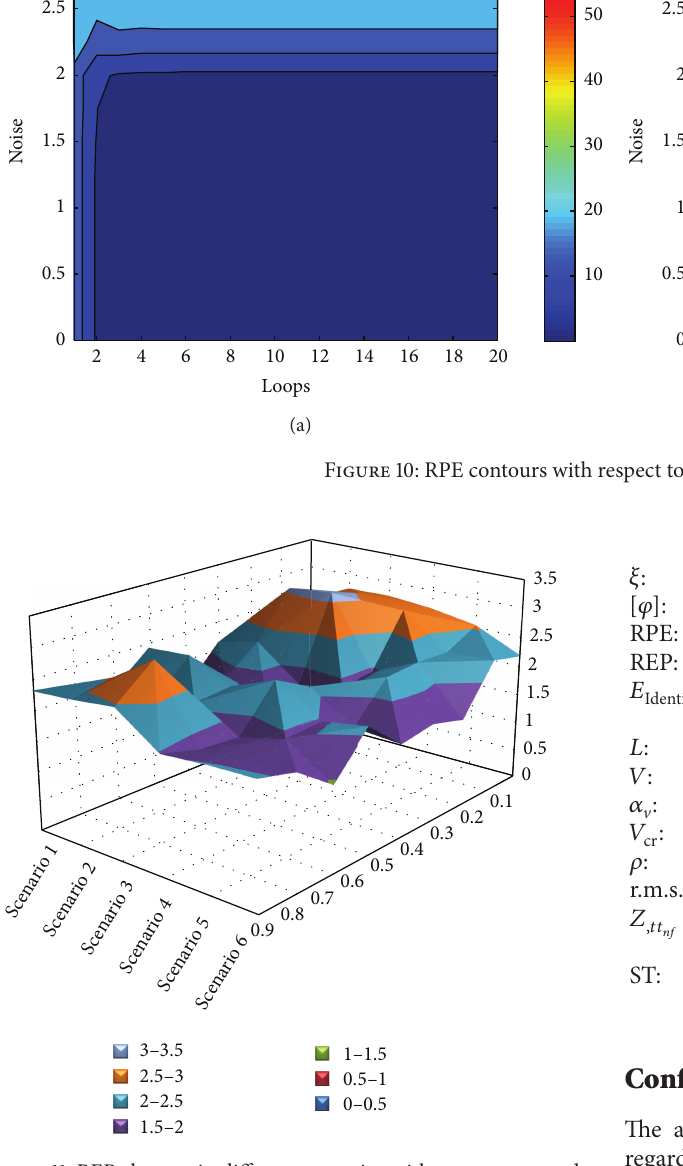
Figure 11: REP changes in different scenarios with respect to speed parameter for model